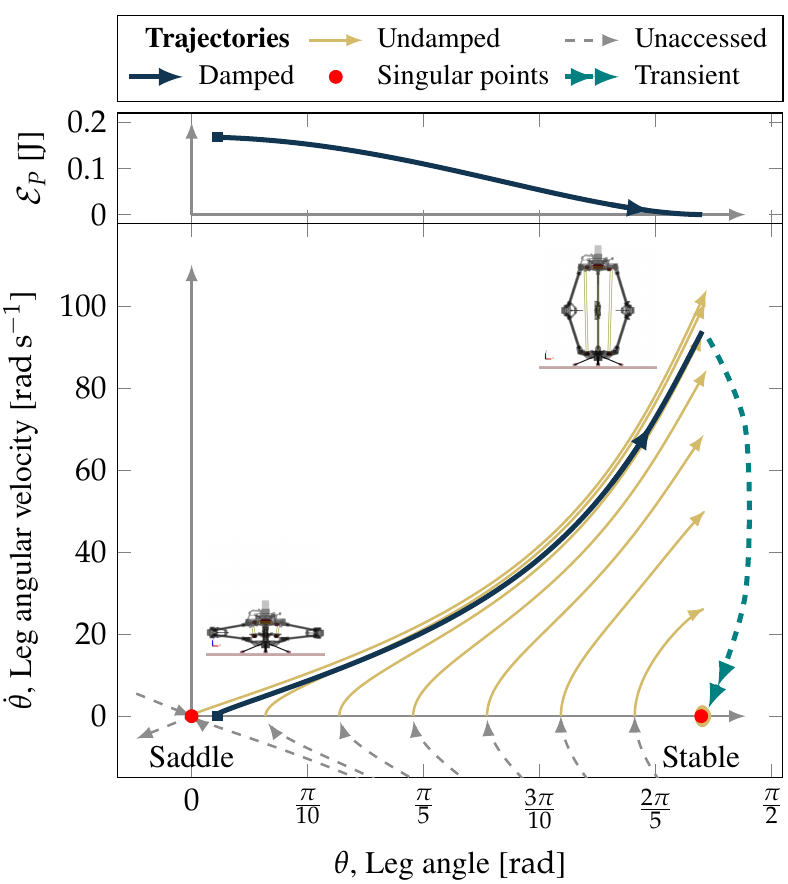
Figure 8. Phase portrait of the trajectories of the dynamical system for the parameters reported in Tables 1 and 2. The damped trajectory characterising the laboratory demonstrator moves from a high potential energy state located near an unstable singular point, to a low potential energy state during linkage decompression. If the rotational kinetic energy ( E P E K converted to ) in the linkage is damped out, then the trajectory of the dynamical model will move towards the stable singular point and remain idle afterwards. Undamped trajectories, i.e., µ C = 0, are shown for reference.